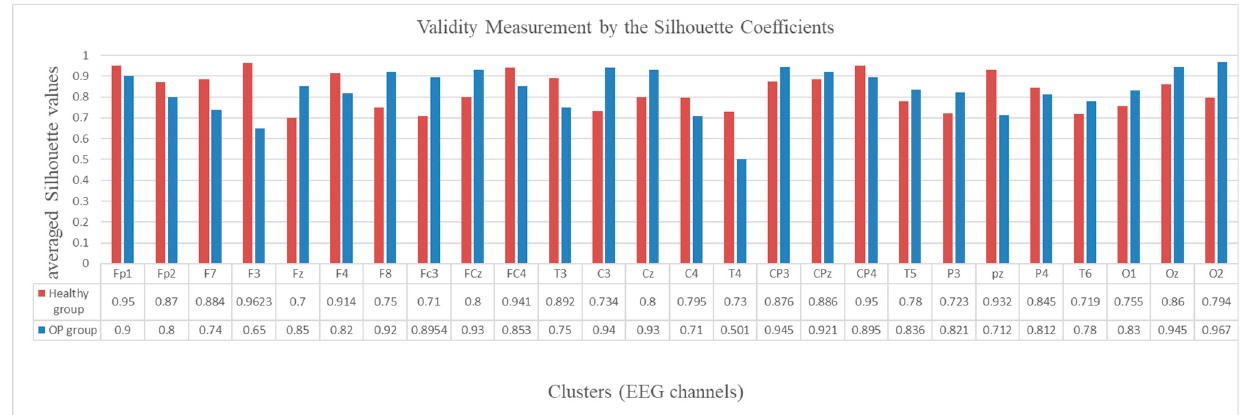
Figure 12. Validity measurement of the clusters generated in the SNN models of EEG data with 26 channels from the healthy control (red bar) and OP group (blue bar). The silhouette value was measured for every neuron in a cluster. Then the silhouette values were averaged over all the neurons in a cluster and represented as a validity metric for this cluster.